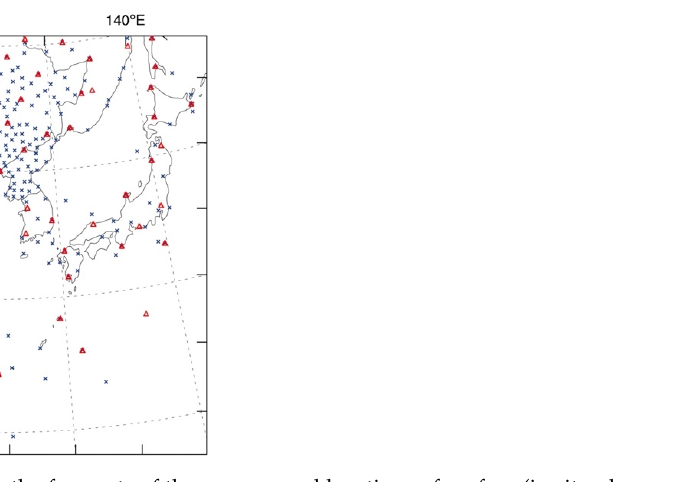
Figure 2. WRF domain for the forecasts of three cases, and locations of surface (in situ observations, ships, and buoys; blue crosses) and sounding stations (red triangles).